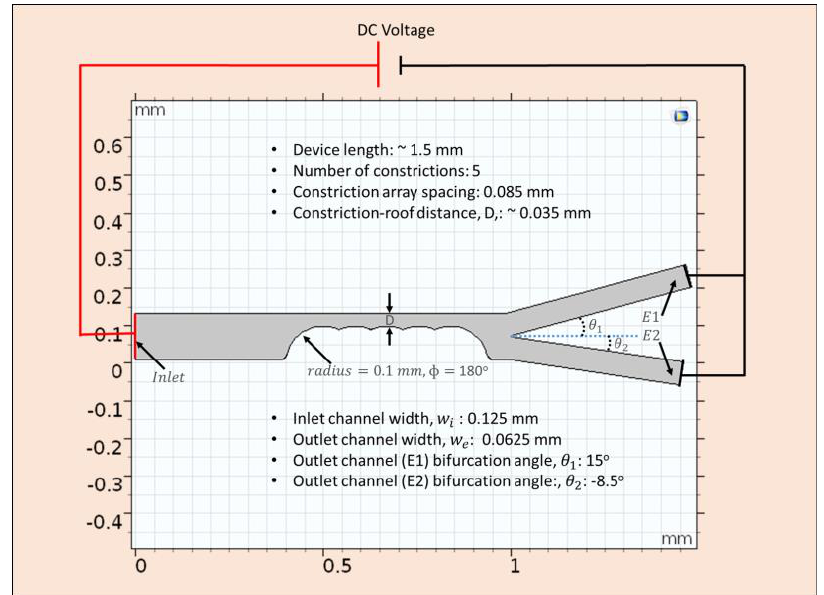
Figure 2. Optimal device design geometry obtained by COMSOL modeling and simulation utilizing the electrophysiological properties of PBMCs and ADCs from the PDMS microwell. Entire microfluidic platform is ~1.5 mm with semi-circular constrictions embedded in the channel. Inlet channel is 125 µ m wide and the two outlet channel widths are ~62.5 µ m. Pt electrodes in the inlet and outlet ports is connected to a DC power supply to further sort ADCs from healthy